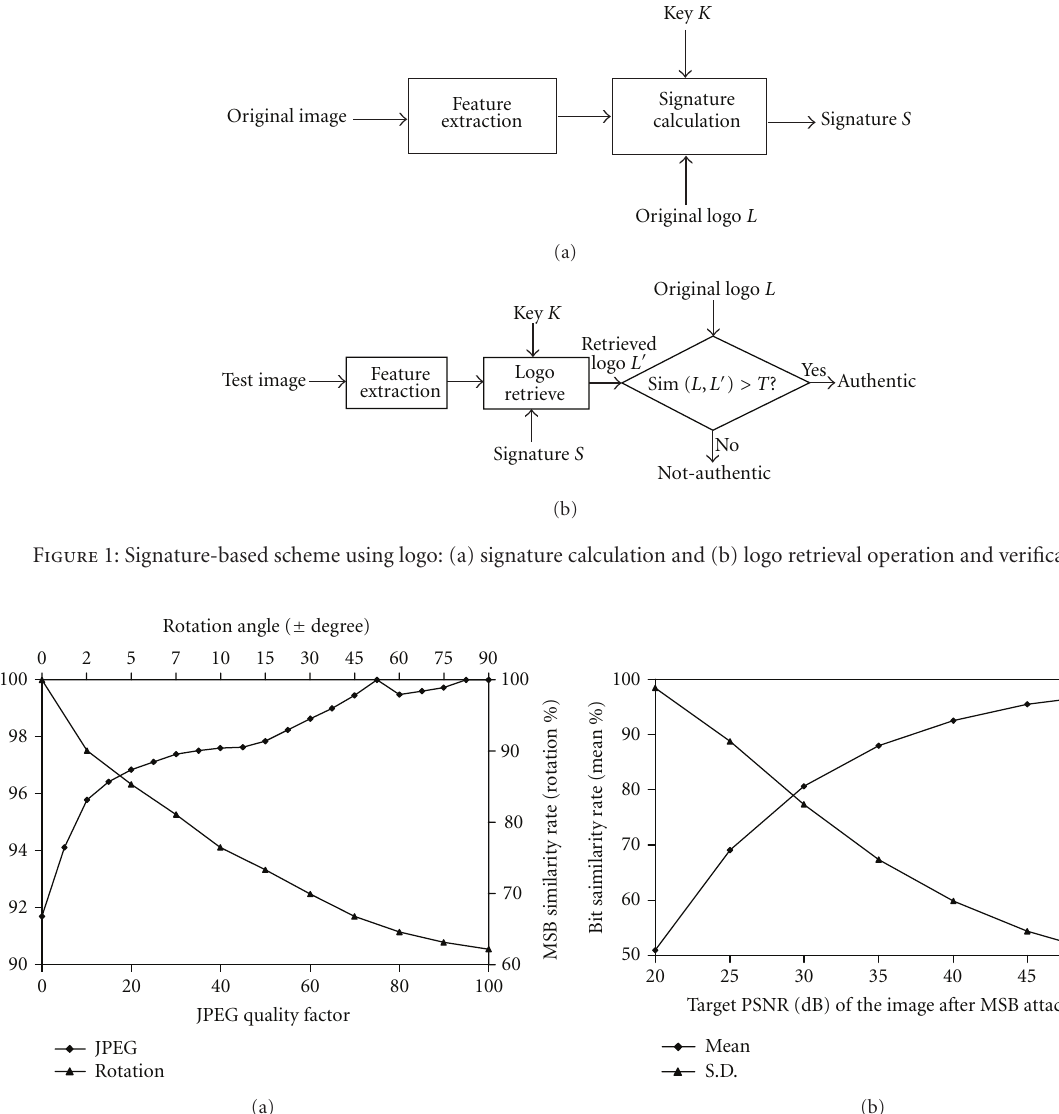
the original image size is small as demanded by the